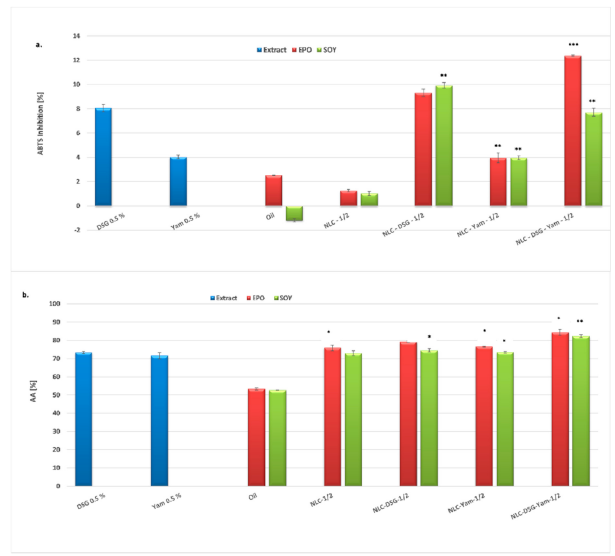
Figure 8. Antioxidant ability of NLC-DSG-Yam, determined by: A. TEAC assay ( a ); B. chemilumines- cence method ( b ) * p < 0.05; ** p < 0.005; *** p < 0.0005; NS p > 0.05 (NS). Data are expressed as mean ± SD, n = 3 NLC-1/2 vs. other groups.